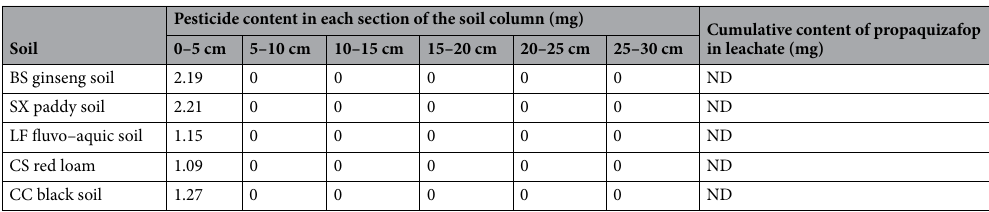
Table 7. Distribution of propaquizafop in the column filled with different soils.